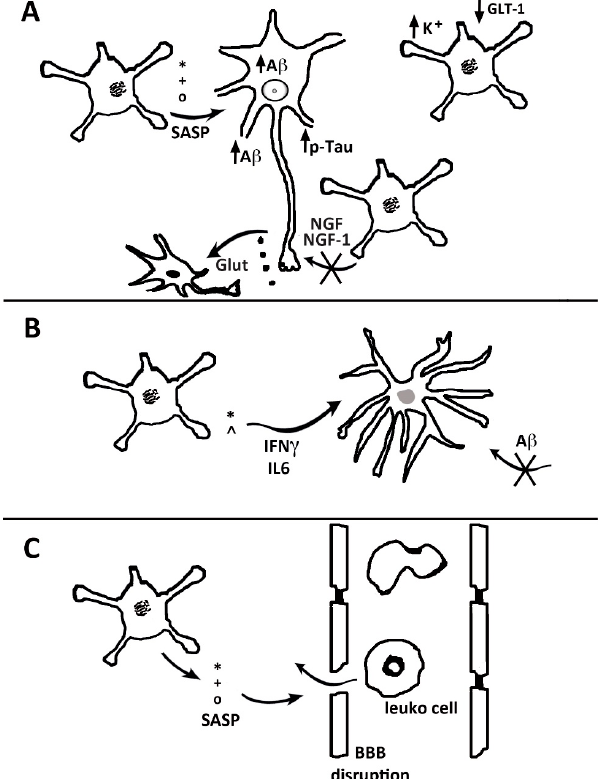
Figure 2. Role of senescent astrocytes in the neuronal, microglial and vascular pathologies. In ( A ), senescence-associated secretory phenotype (SASP) factors (*, +, °), released by senescent astrocytes (striped nuclei), increase in neurons the generation and deposition of A β together with the phosphorylation of tau. Neurons release glutamate (black dots, Glut), which cannot be cleared from the synaptic environment by senescent astrocytes, leading to an accumulation of extracellular excitotoxic glutamate. Together with the reduced secretion by senescent astrocytes of neurotrophic and growth factors (NGF and IGF-1), the excess glutamate may lead to decreased neuronal growth and/or increased neuronal death (black nucleus). In ( B ), a senescent astrocyte secretes IFN γ and IL-6, which activate microglia (gray nucleus) and reduce the A β uptake. In ( C ), SASP factors disrupt the endothelial tight junctions, inducing local BBB disruption with leukocyte transmigration.